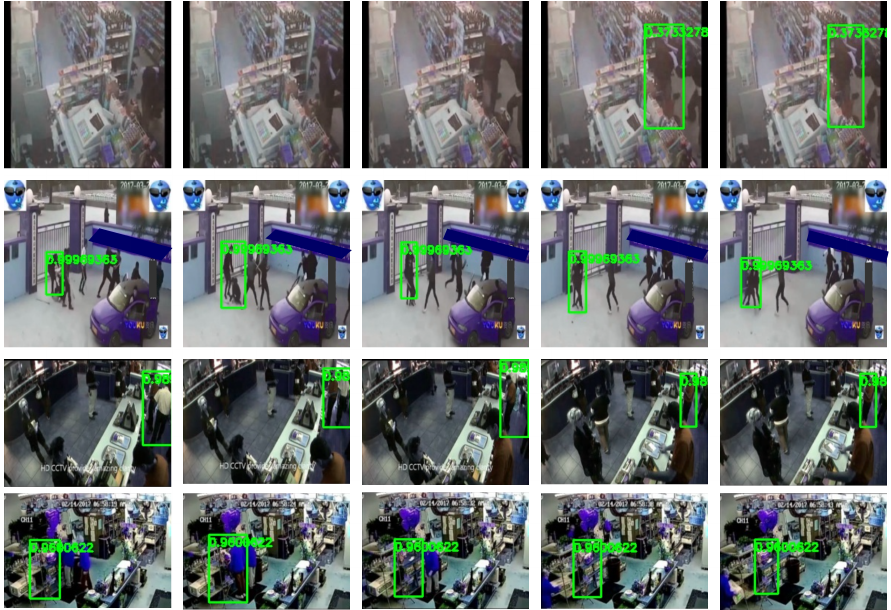
Figure 12. Qualitative examples of failure cases of the proposed model. The action tube and its score are presented in green.